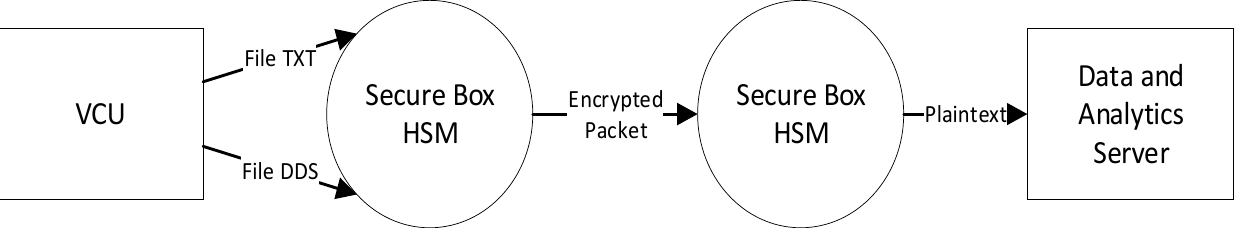
Figure 5. Securebox HSM DFD Level 0.